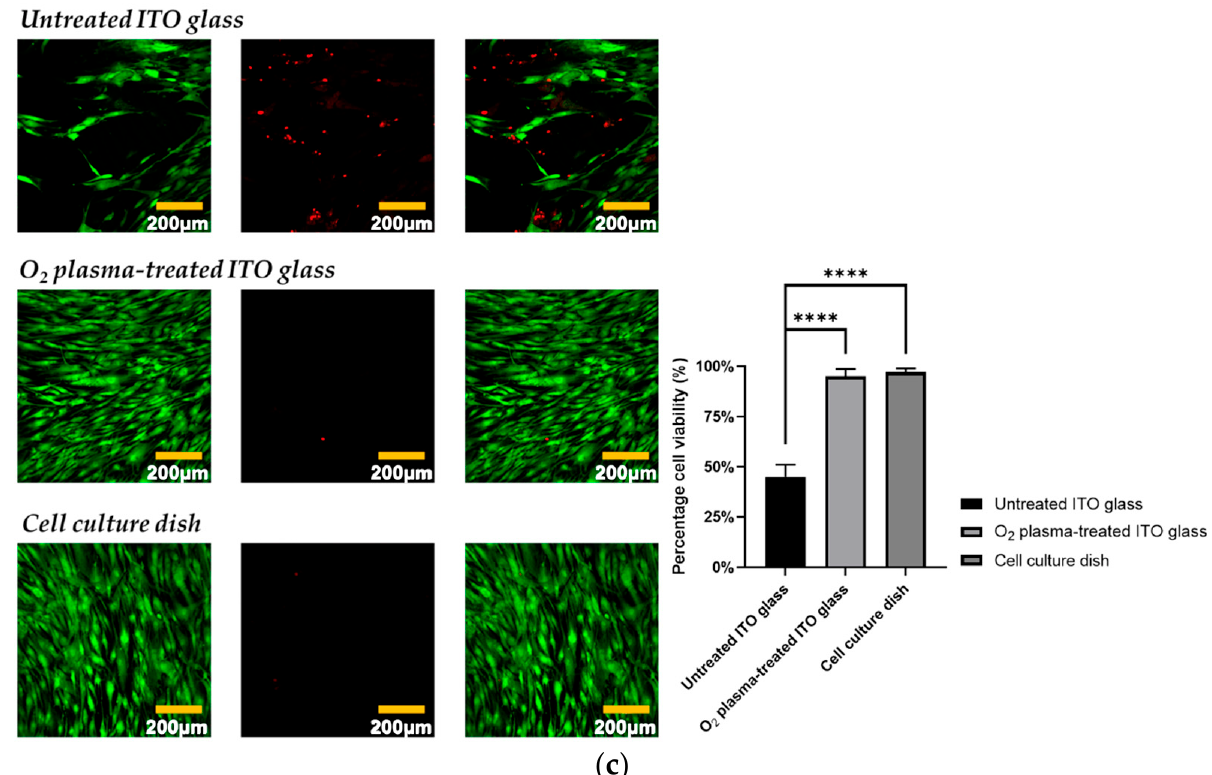
Figure 1. ( a ) Schematic of the O 2 plasma treatment process for wettability and hydrophilicity of O 2 glass surface. ( b ) Untreated ITO glass and O 2 plasma-treated ITO glass conductivity test. ( c ) hADMSC cytotoxicity test on untreated ITO glass, O 2 plasma-treated ITO glass, and a standard cell culture dish (green fluorescence—live cells, red fluorescence—dead cells)/a percentage of cell viability graph data were analyzed with one-way ANOVA and Tukey’s HSD post-hoc test (error bars represent the standard deviation (SD), **** p < 0.0001).